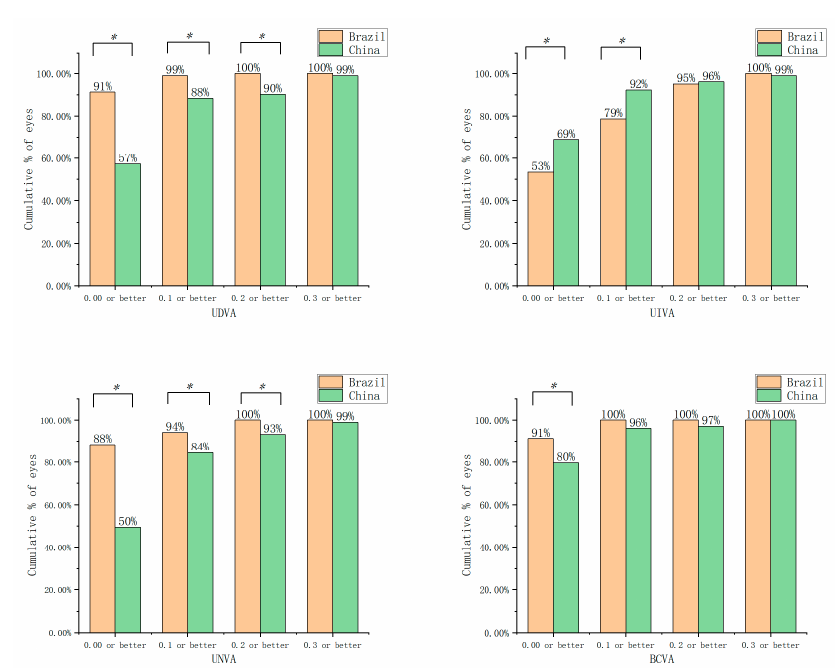
Figure A1. Cumulative monocular distance, intermediate, near uncorrected visual acuity, and best corrected visual acuity at 3 months postoperatively (* means significant differences were found between the two groups).